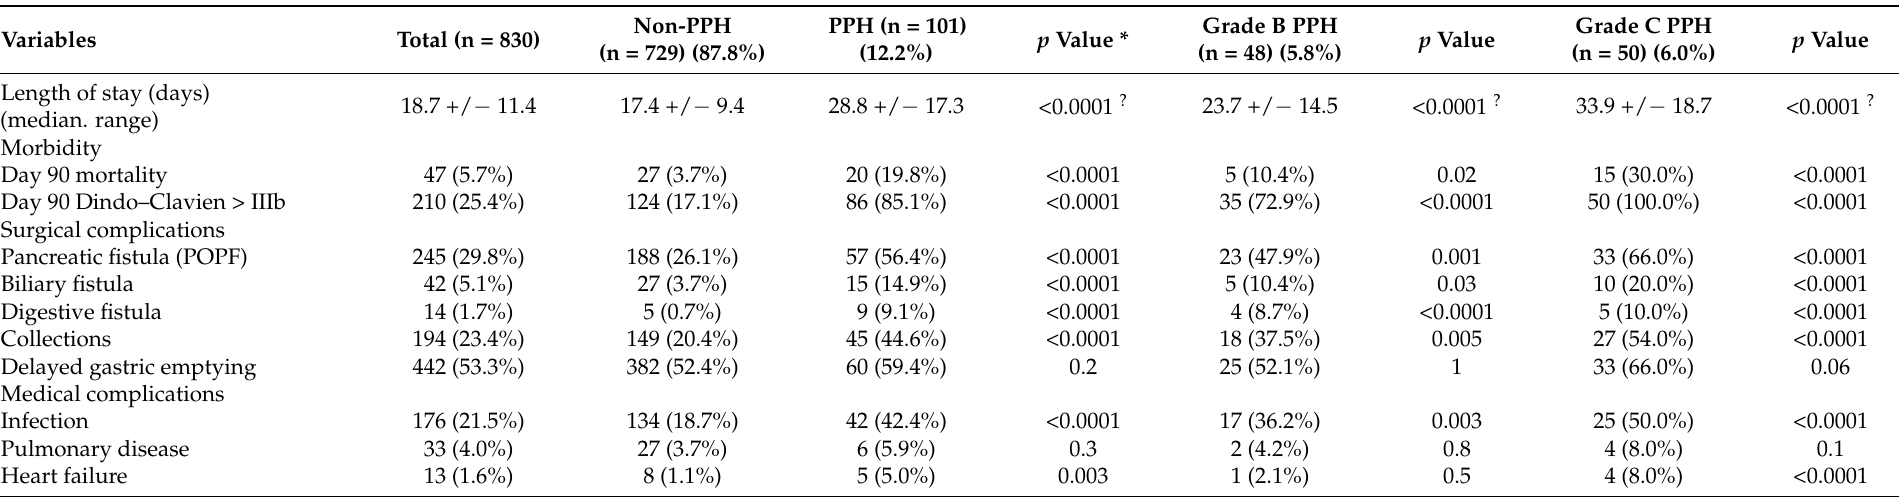
Table 2. Morbidity and mortality in the PPH and non-PPH groups (* Chi-squared test, ? Student t -test). Grade B and C PPH groups are compared to the non-PPH group (with only 3 patients, the grade A PPH group does not appear in the table).